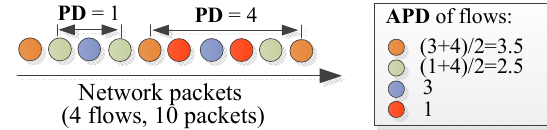
Figure 4. Procedure of flowkey insertion.